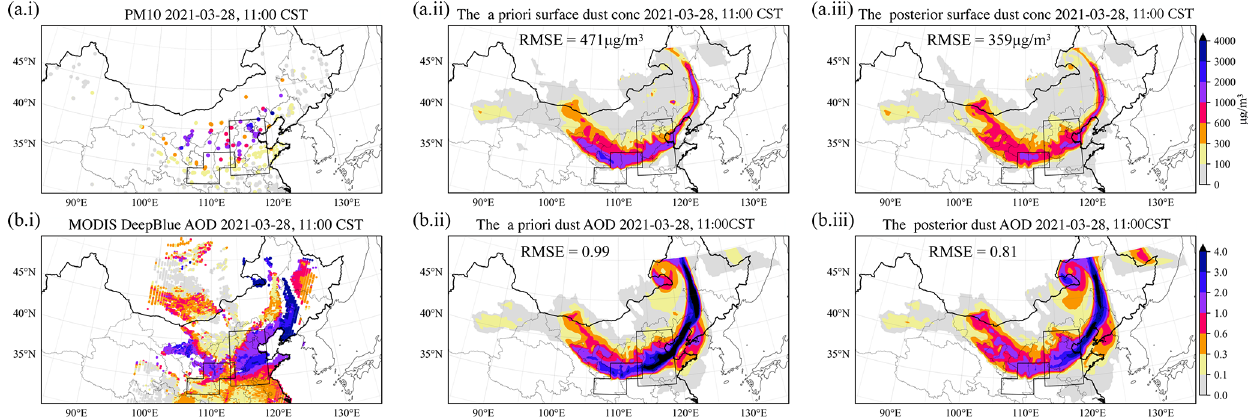
Figure 3. Snapshots of observations and simulations during severe dust event 2 (SD2) at 28 March 2021. Row (a) shows PM 10 concentrations observed by ground network at 11:00CST (i) , a priori (ii) , and posterior (iii) simulations by the LOTOS-EUROS/dust model. Row (b) shows for the same hour AOD at 550nm from MODIS Deep Blue observations (i) and simulations (ii–iii)